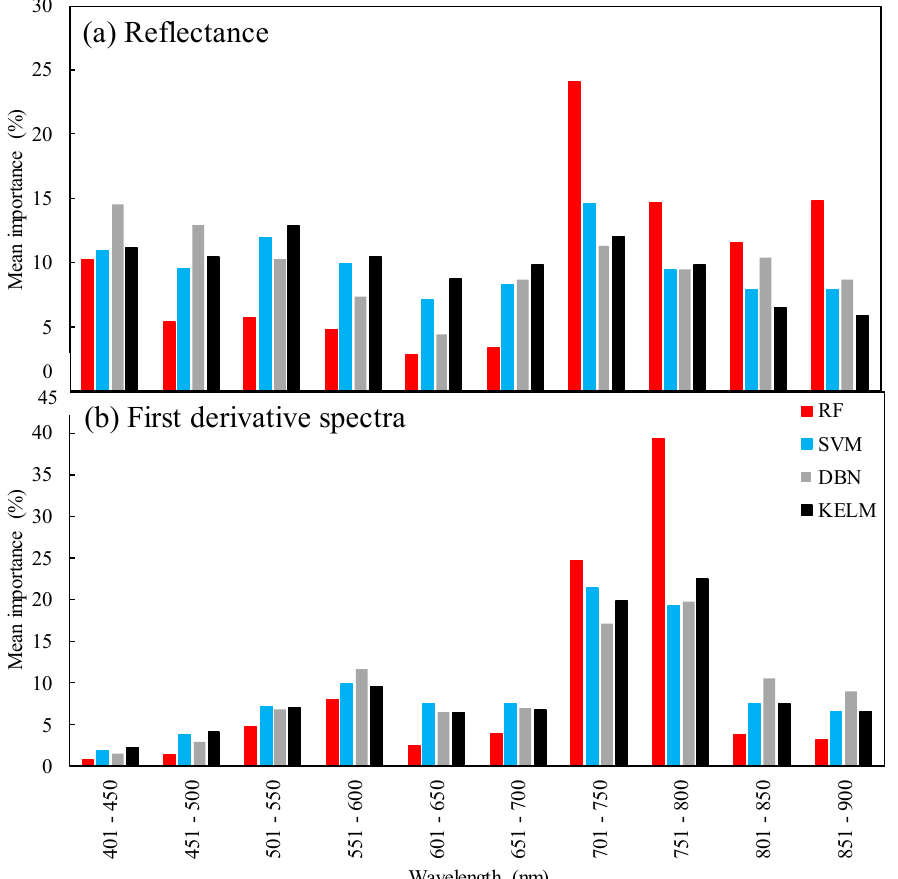
Figure 8. Data-based sensitivity analyses (DSA) results for random forest (RF), support vector machine (SVM), deep belief nets (DBN), and kernel-based extreme learning machine (KELM) from ( a ) reflectance and ( b ) first derivative spectra. Values were averaged over 100 replicates.